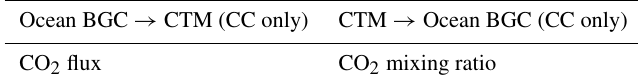
Table 9. Variables exchanged with a 24h frequency between the chemical transport model TM5 and the ocean biogeochemistry model